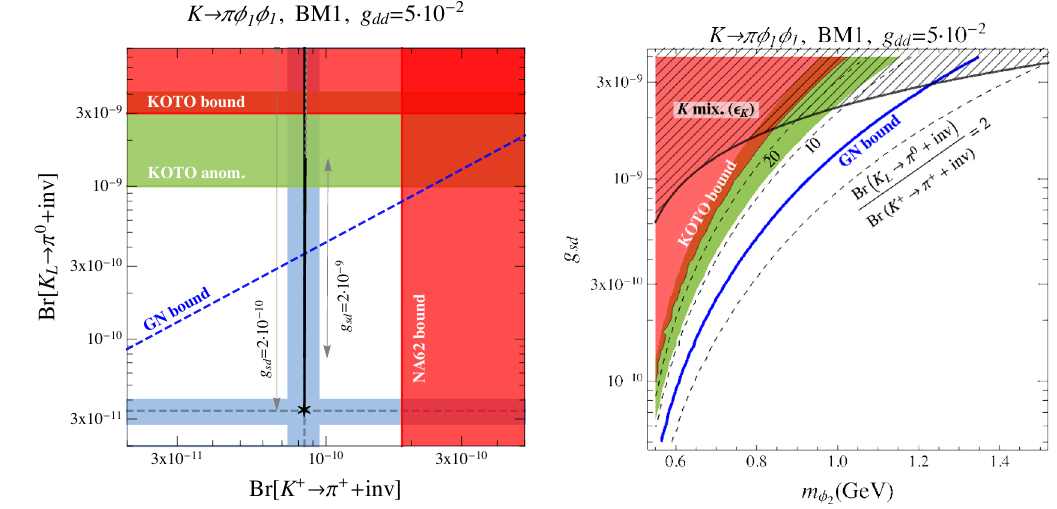
Figure 15 . The parameter space for Model 2, BM1, eq. (4.6). The color coding is the same as (cid:25) + + inv), Br( K L (cid:25) 0 + inv) on the left plot (black in (cid:12)gure 5. In the predictions for Br( K + ! ! lines) we vary m (cid:30) [0 : 55 ; 1 : 5] GeV for two values of g sd = 2 10 (cid:0) 10 ; 2 10 (cid:0) 9 . 2 2 (cid:2) (cid:2)